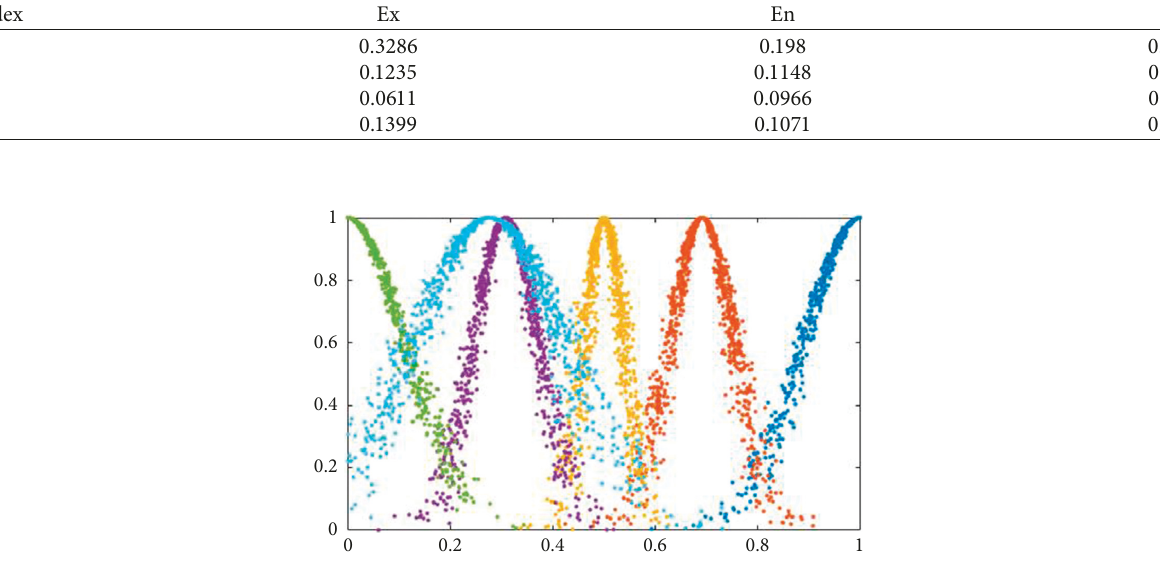
Figure 5: Comprehensive cloud map.